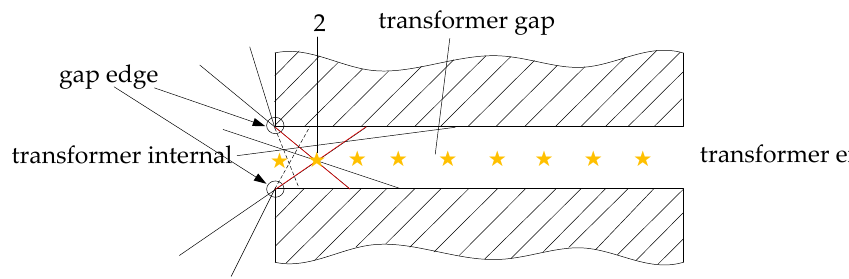
Figure 4. Schematic diagram of incidence of electromagnetic wave in transformer gap entrance.